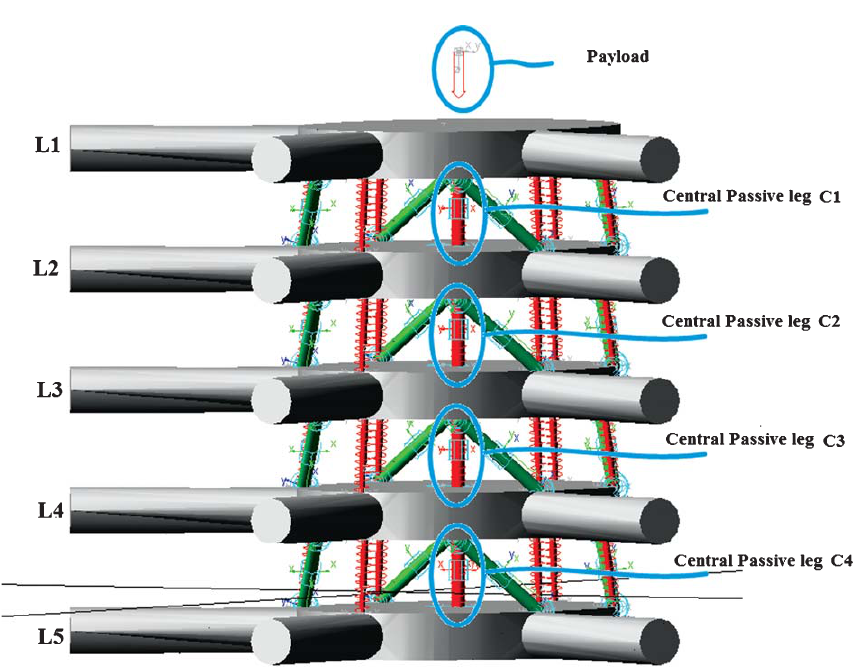
Fig. 7. A 3D ADAMS model with general parts